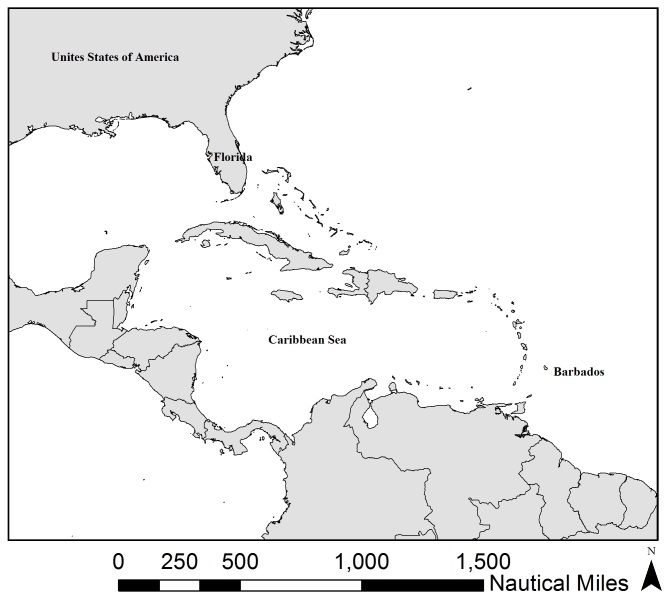
Caribbean Region